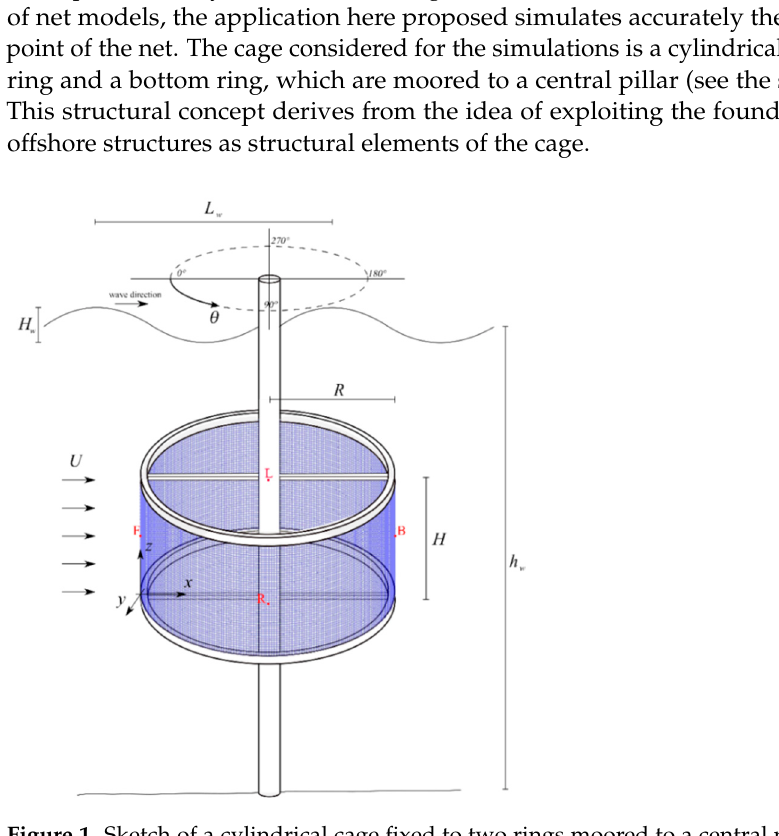
Figure 1. Sketch of a cylindrical cage fixed to two rings moored to a central pillar. Red points are reference locations for the analyses.